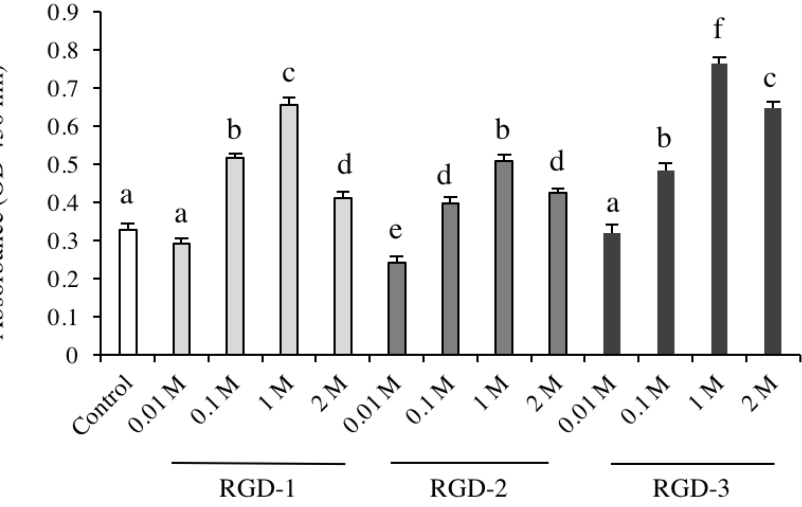
Figure 2. Effects of DPP-derived RGD peptides on the proliferation of hDPSCs. Plates were coated with different concentrations of soluble RGD-1, RGD-2 or RGD-3 in the experiment groups, and in the control group, plates were coated with dH 2 O. After four days of culture, absorbance was measured using a microplate reader, OD = 450 nm. Significant differences were observed between the control and RGD-coated groups. RGD at a concentration of 1 M (0.5 mg/mL RGD-1, 0.36 mg/mL RGD-2 and 0.36 mg/mL RGD-3) maximized cell proliferation. n = 6, different lowercase characters denote significant differences compared to the control ( p <